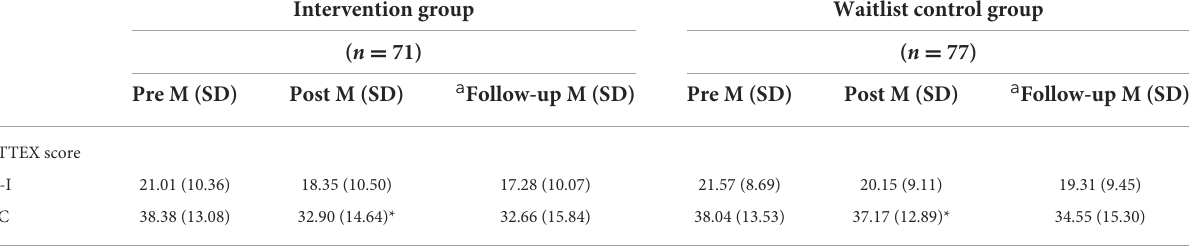
TABLE 3 ATTEX scores at pre-, post-, and follow-up assessments. Intervention group